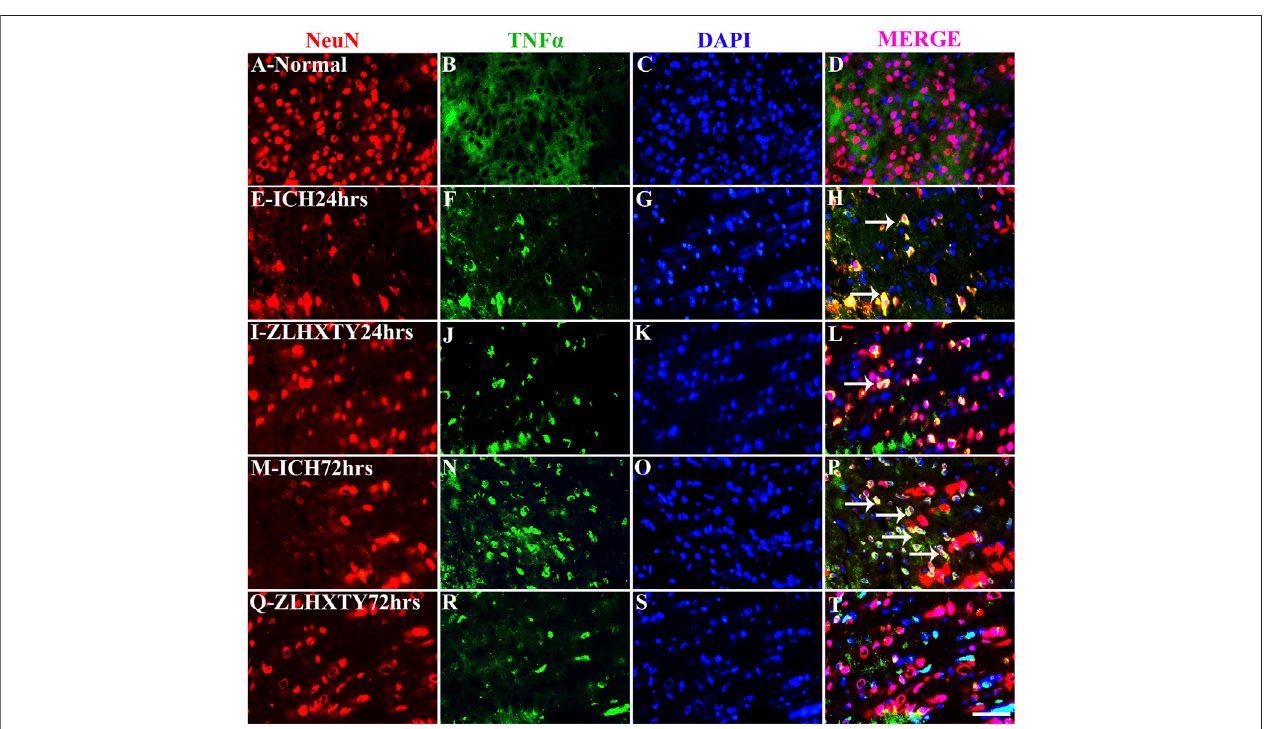
FIGURE 6 | Double immuno fl uorescence of NeuN and TNF α . Brain sections were triple-stained with anti-NeuN (red), anti-TNF α (green) and DAPI (blue) to mark neurons, TNF α and nucleus. (A – D) , Normal brain section shows only NeuN staining. (E – H) , ICH 24 h group show decreased NeuN expression and increased neuronal TNF α expression, seen as yellow colour in merge. (I – L) , ZLHXTY 24 h group shows increased NeuN expression and reduction in TNF α expression. (M – P) , ICH 72 h show reduced NeuN expression and marked increase in neuronal TNF α expression (yellow in merge). (Q – T) , ZLHXTY 72 h group show reduced neuronal TNF α expressionandincreasedNeuN.Respectivechangeincolorinmerged fi guresD,H,L,P,T,correspondstoRed+Blue=Magenta;Red+Green=Yellow.50 µmscalebar corresponds to 400 × magni fi